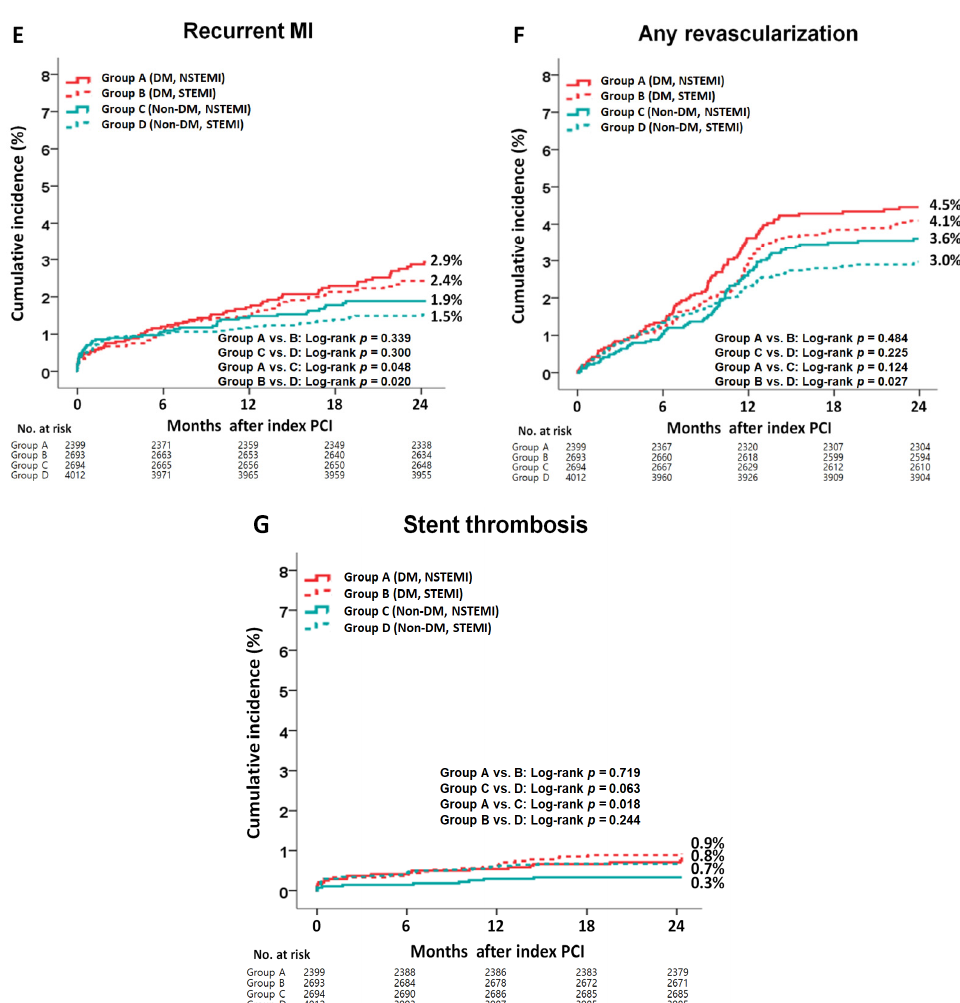
Figure 2. Kaplan–Meier curved analysis for MACE ( A ), all-cause death ( B ), cardiac death ( C ), non-cardiac death ( D ), recurrent MI ( E ), any repeat revascularization ( F ), and stent thrombosis ( G ). MACE, major adverse cardiac events; DM, diabetes mellitus; NSTEMI, non-ST-segment elevation myocardial infarction; STEMI, ST-segment elevation myocardial infarction; PCI, percutaneous coronary intervention.